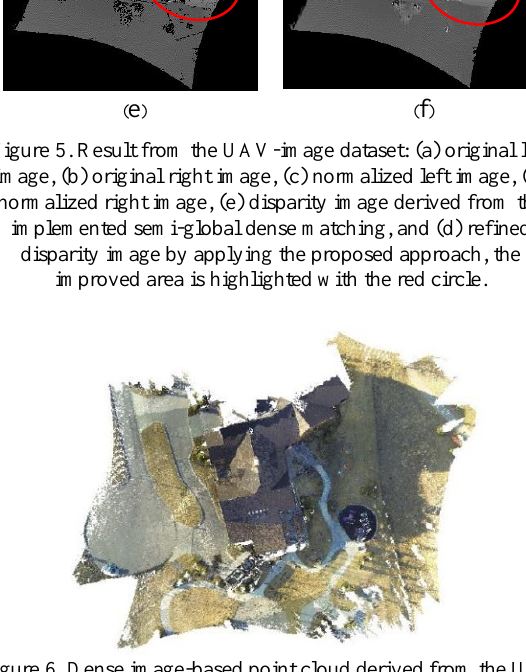
Figure 6. Dense image-based point cloud derived from the UAV image dataset after applying the proposed disparity refinement